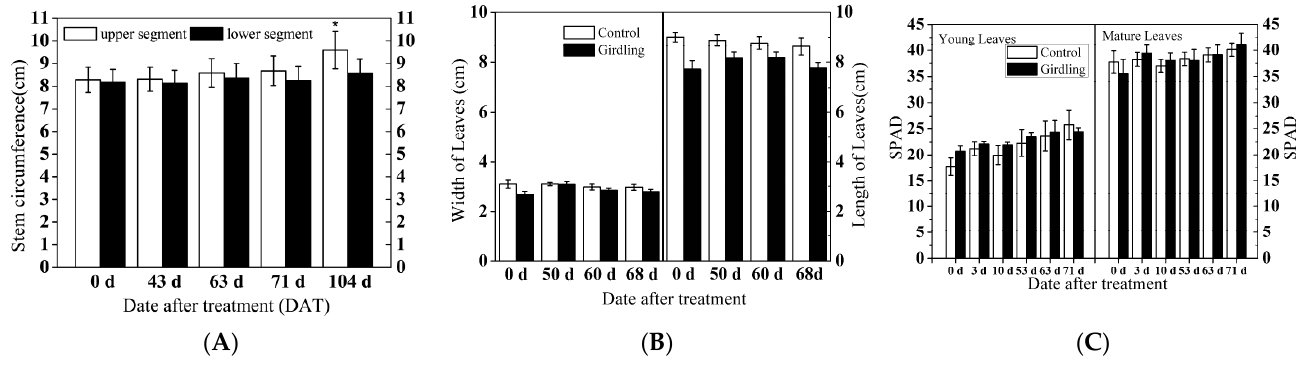
Figure 2. The growth of litchi trees was suppressed by cold treatment. ( A ): Variations between the upper and lower segments of the girdle. Asterisks (*) indicate significant differences determined by an unpaired t -test at p < 0.05. ( B ): Length and width of leaves in the terminal shoots. ( C ): Measurement of SPAD value of the leaves on the terminal flushes. SPAD, value of Soil and Plant Analyzer Development, represented Chlorophyll content. Table 1. Litchi flowering time and quantities in response to girdling and cold temperature treatment.